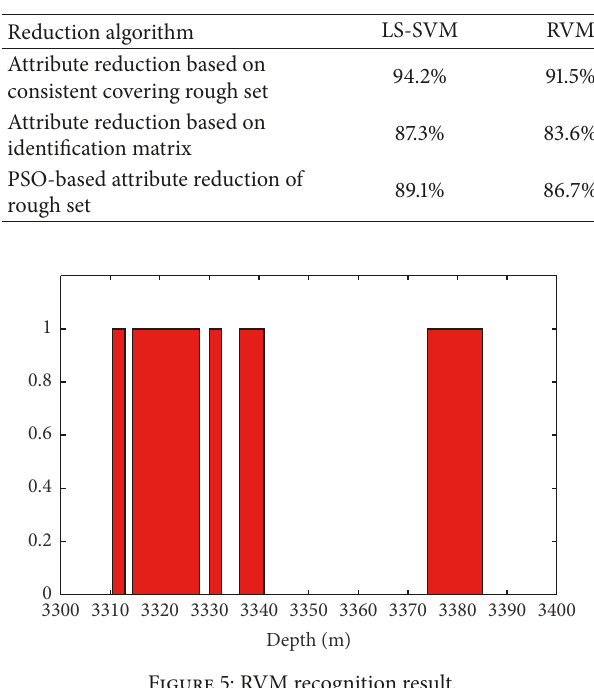
Table 7: Comparison of recognition accuracy.